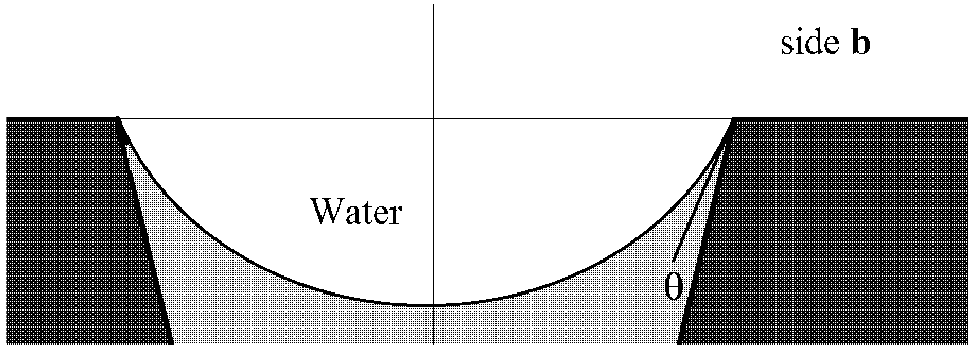
Figure 9. Scheme of the interaction of the water–insoluble organic liquid with the surface of the material and water on side b